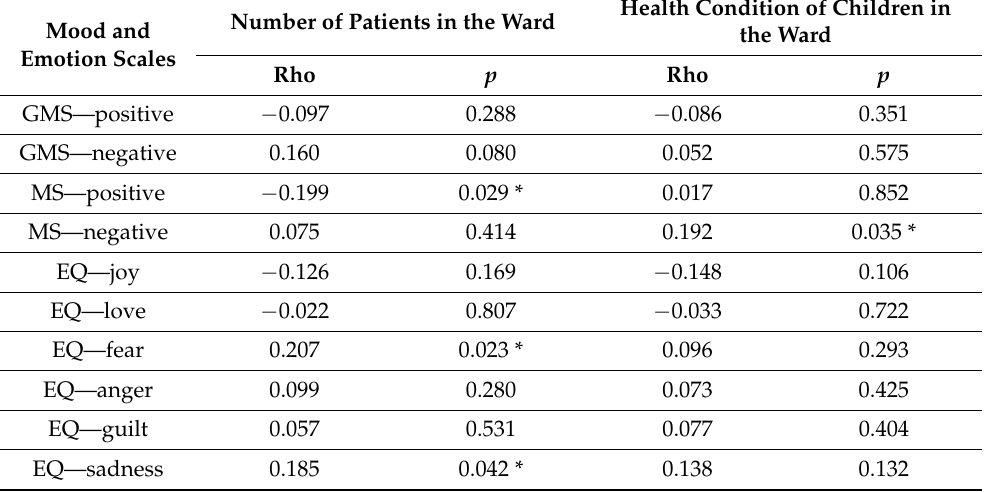
Table 6. The number of patients in the pediatric ward and their health condition, and the mood and emotions. Health Condition of Children in Number of Patients in the Ward Mood and the Ward Emotion Scales Rho p Rho p GMS—positive − 0.097 0.288 − 0.086 0.351 GMS—negative 0.160 0.080 0.052 0.575 MS—positive − 0.199 0.029 * 0.017